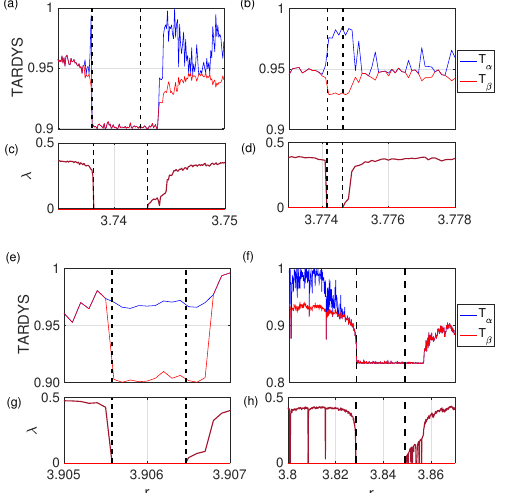
Figure 5. ( a , b , e , f ) Details around some of the periodic regions in the logistic map that show that T α (cid:54) = T β right before and after entering the periodic window. ( c , d , g , h ) Corresponding Lyapunov